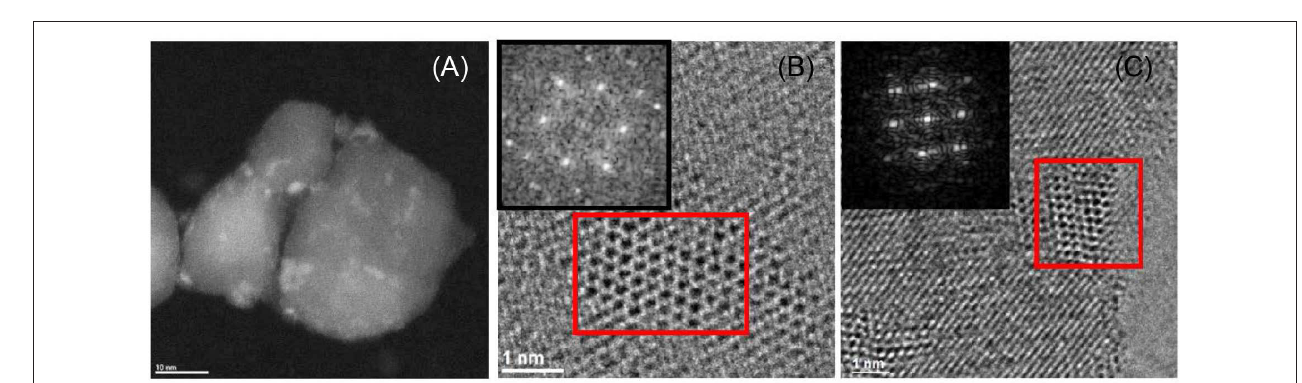
FIGURE 4 | Representative STEM image of MoN B /TiO 2 -D (A) ; TEM images and electron diffraction patterns (corresponding to the red squares in the images) of MoN B /TiO 2 -D (B) and MoN A /ZrO 2 (C)